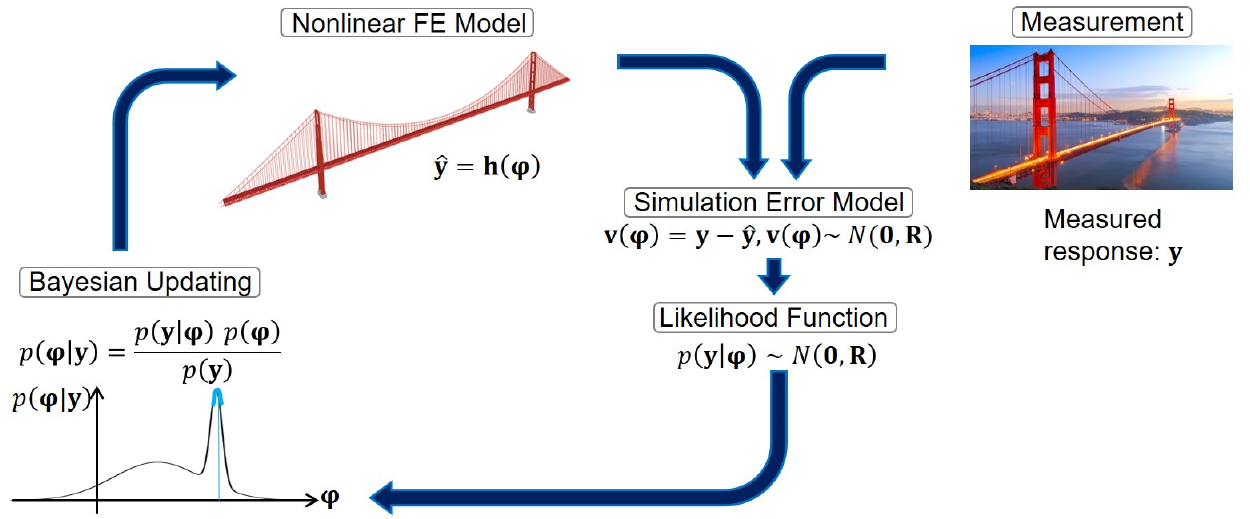
Figure 1. Schematic representation of the sequential Bayesian inference method for model updating.